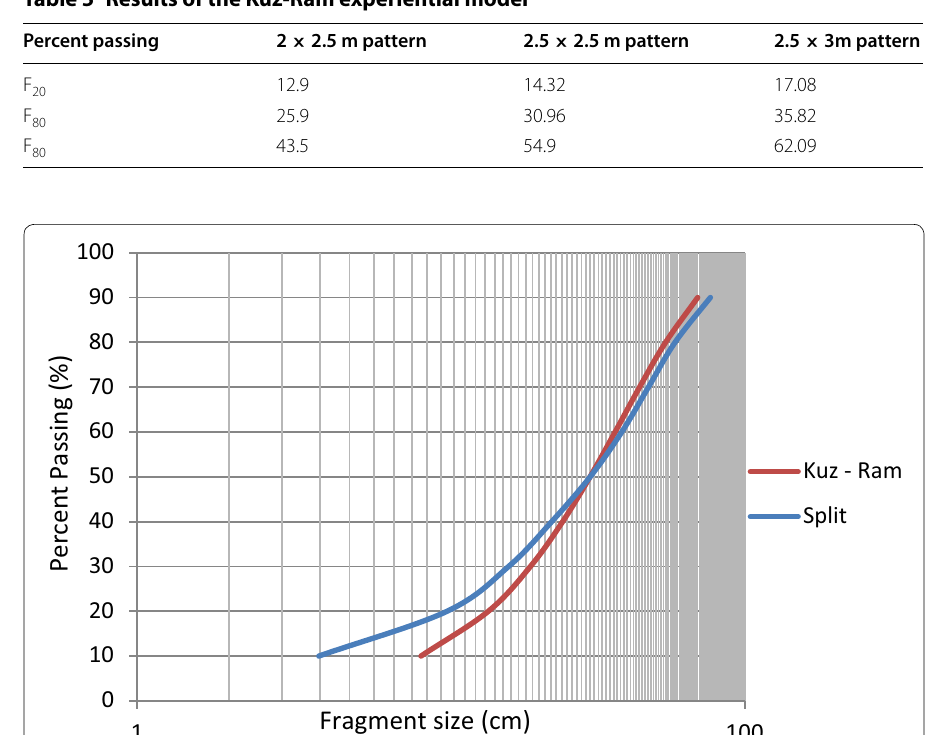
Fig. 4 Diagram obtained from the Kuz-Ram experiential model and digital image analysis in Split Desktop for pattern No.